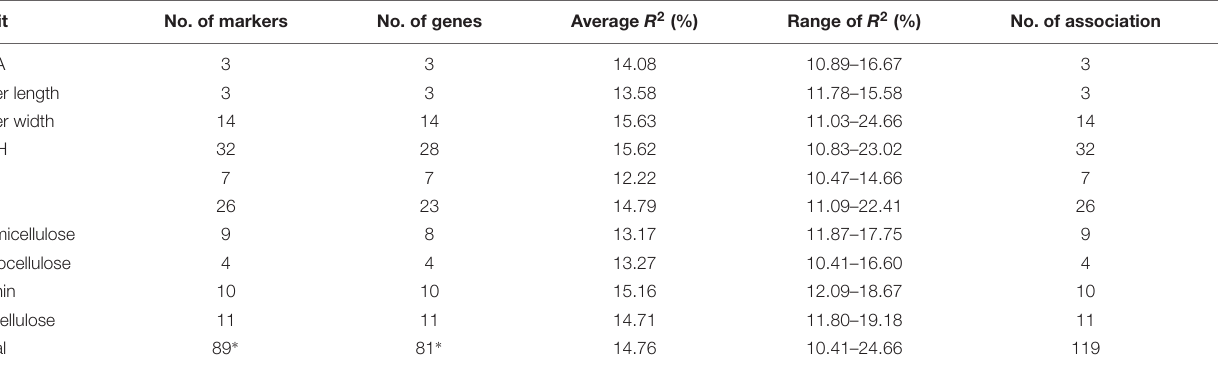
FIGURE 2 | Characterization of genic-InDels in the P. tomentosa natural population. (A) Distribution pattern of genic-InDels. The distribution of total InDels among the different gene regions was shown on the left. The rates of diallelic/complex InDels and insertions/deletions were shown on the right. (B) InDels occurred within exon regions. A deletion of CGCAACCAA (dashed box) in Potri.016G080500 that caused a deletion of three amino acids [Arg(R)-Asn(N)-Gln(Q)] was shown in the upper figure. Two deletions within Potri.012G046600 that caused a frameshift (dashed box) were shown in the lower figure. (C) The length and distribution frequency of genic-InDels. The frequency distribution of InDels with different sizes (left) and the P–P plot of the frequency distribution trend (right) were shown. (D) Distribution patterns of common and unique alleles (pie charts) among the three climatic regions of P. tomentosa . The red, blue, and yellow regions represent the northeastern region (NE), the northwestern region (NW), and the southern region (S) of the P. tomentosa natural population. TABLE 1 | Summary of the significant InDel marker associations tested in the P. tomentosa natural population with the positive false discovery rate (FDR) q < 0.10. Trait No. of markers No. of genes Average R 2 (%) Range of R 2 (%) No. of